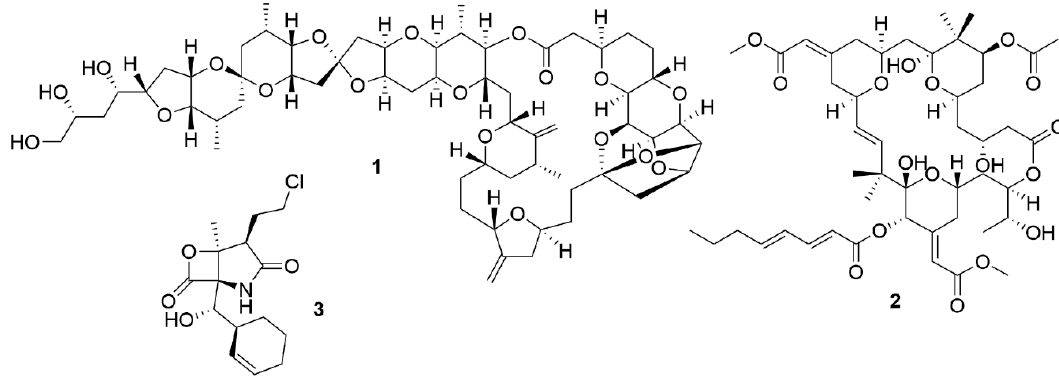
Figure 1. Bioactive metabolites isolated from marine organisms. Halichondrin B ( 1 ), a macrolide first isolated from H. okadai but also present in other sponges. Bryostatin 1 ( 2 ), which belongs to a family of polyketide macrolides first identified in the marine bryozoan B. neritina . Salinosporamide A ( 3 ), is a proteasome inhibitor isolated from bacteria from the genus Salinospora and is in phase III clinical trials for the treatment of multiple myeloma.